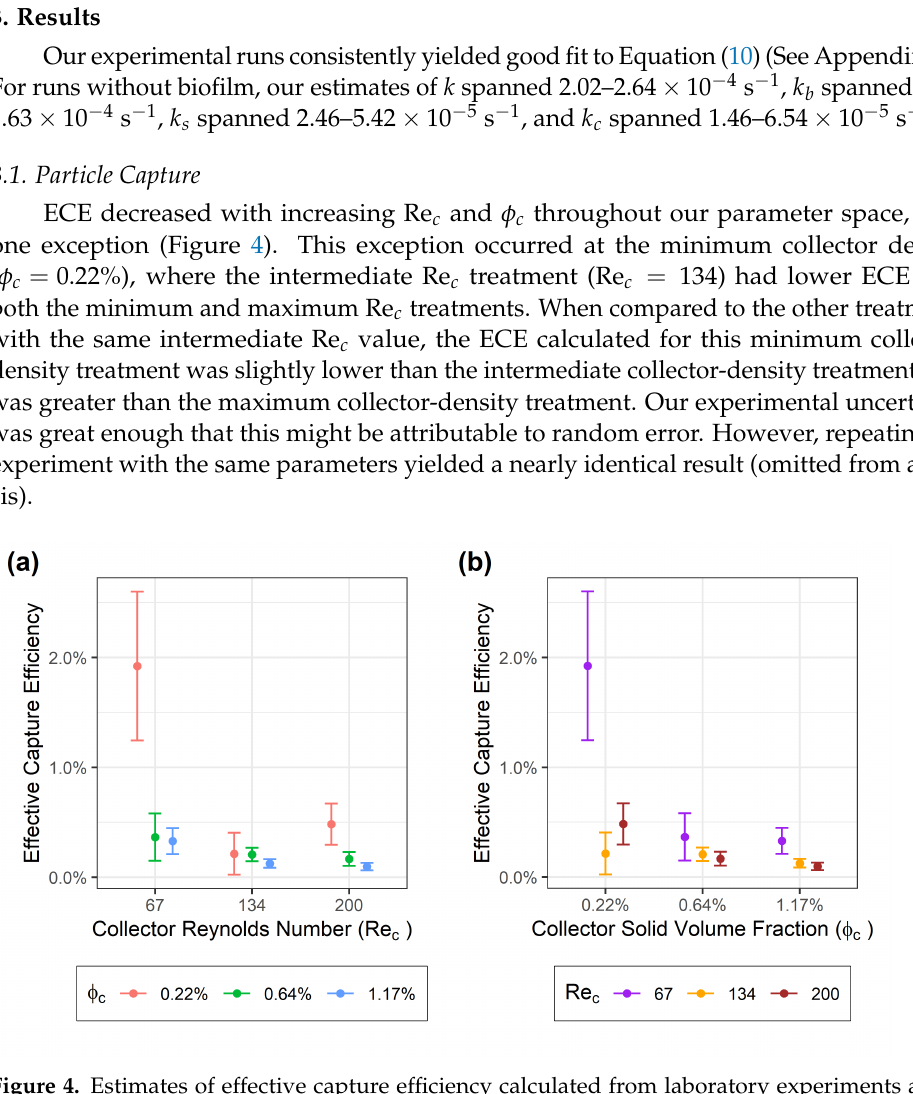
Figure 4. Estimates of effective capture efficiency calculated from laboratory experiments across the collector density × Reynolds number (Re c ) parameter space. Error bars represent ± 1 SE. ( a ) Estimates plotted over Re c , colored by solid volume fraction ( φ c ). ( b ) Estimates plotted over φ c , colored by Re c